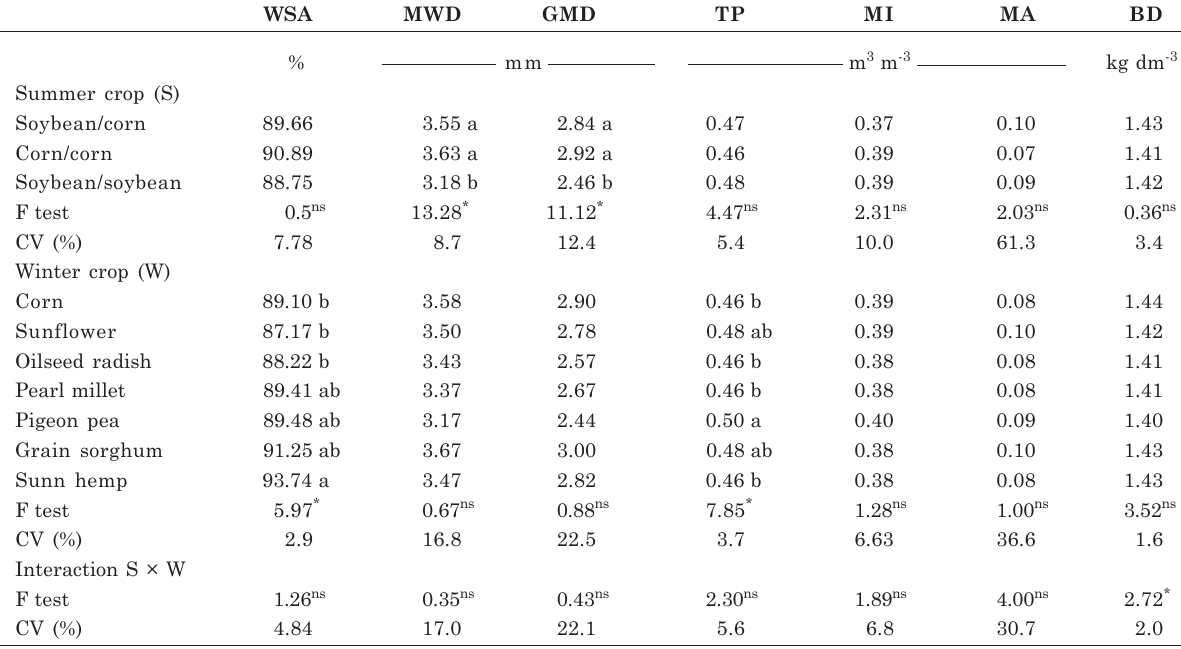
Table 2. Water stable aggregates (WSA), mean weight diameter (MWD), geometric mean diameter (GMD), total porosity (TP), microporosity (MI), macroporosity (MA), and soil bulk density (BD) determined at